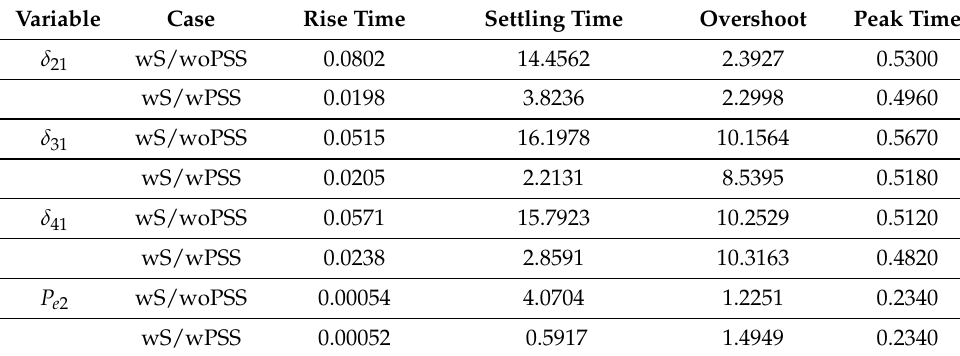
Figure 7. Case 1: ( a ) real power at generator 2; ( b ) voltage magnitude in bus of StatCom connection. Table 5. Analysis in time domain of the responses for case